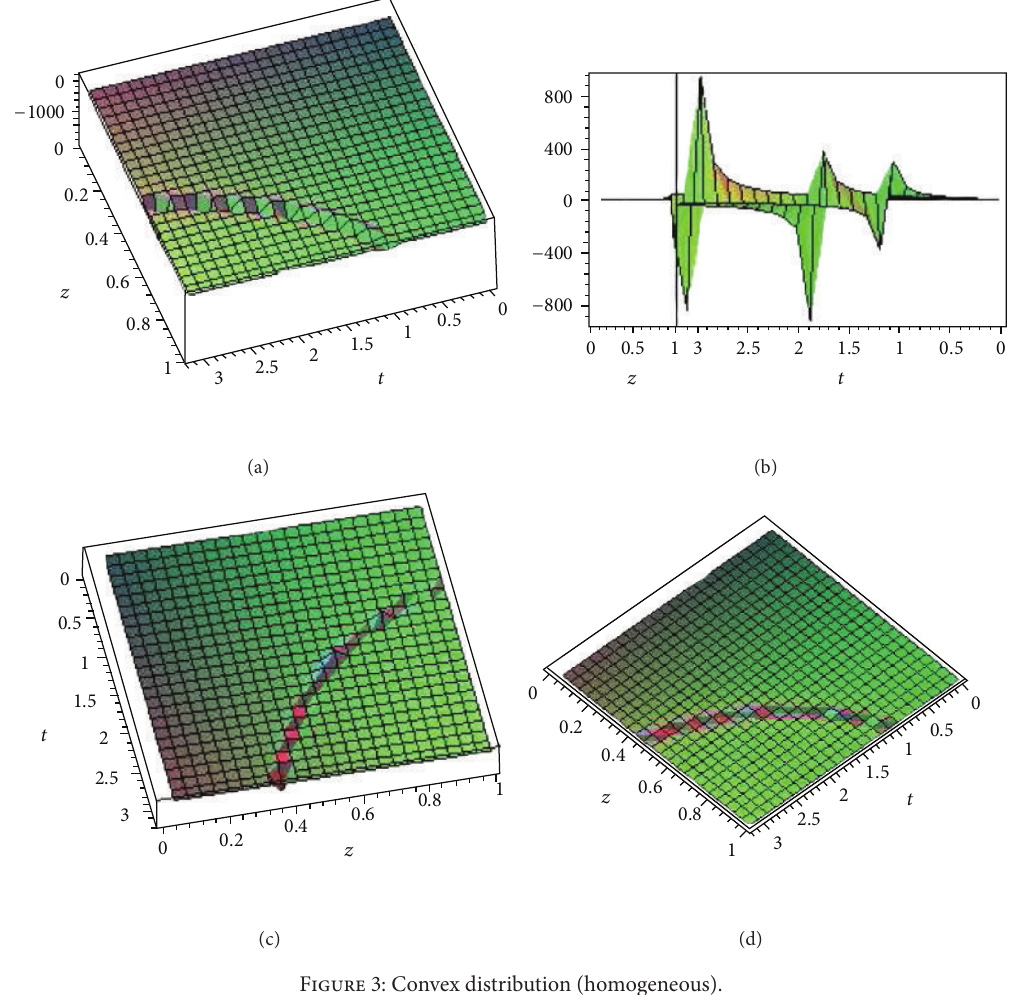
Figure 3: Convex distribution